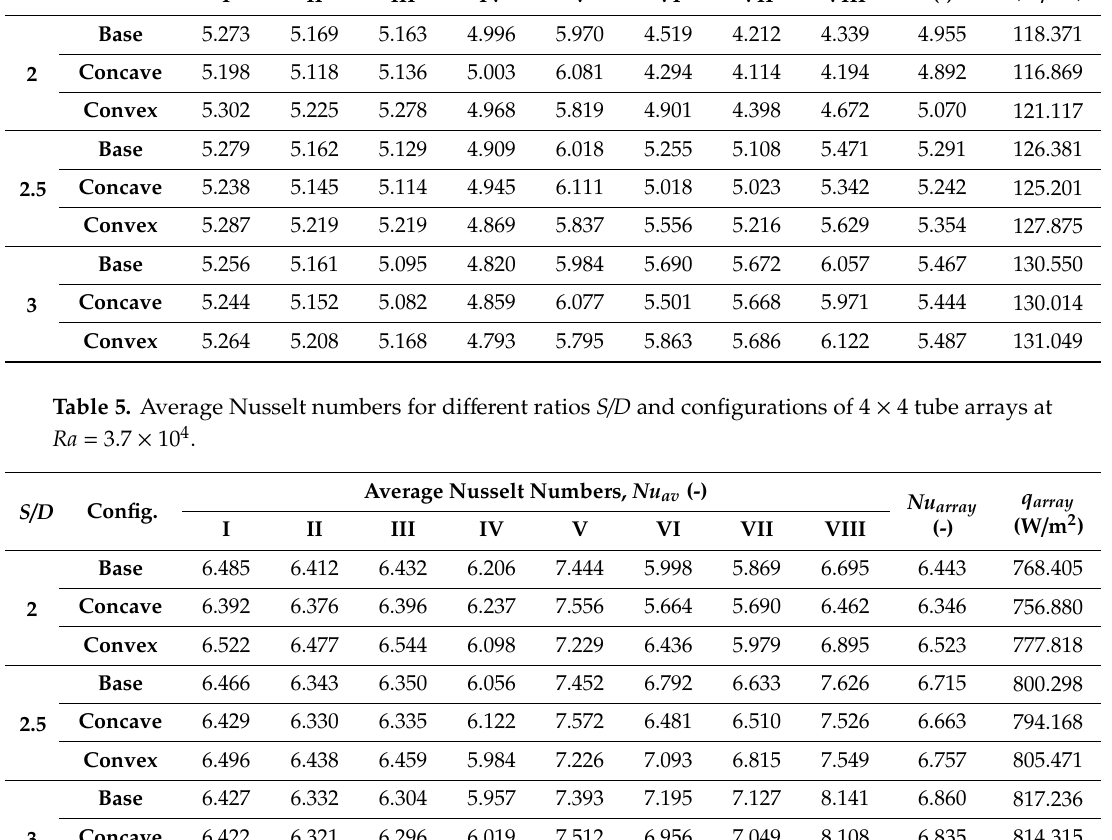
Table 4. Average Nusselt numbers for di ff erent ratios S / D and configurations of 4 × 4 tube arrays at Ra = 1.3 × 10 4 . S / D Config.